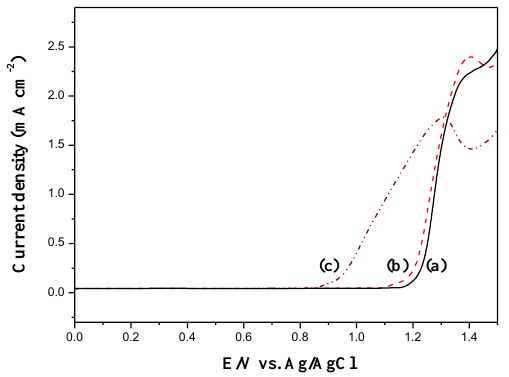
Figure 2. Electrooxidation of ( a ) 4 mM DiCP; ( b ) 4 mM CPDTK; and ( c ) 4 mM CPDT in 0.2 M LiClO 4 containing ACN/DCM (1:1, by volume) solution at a scan rate of 100 mV s −1 .